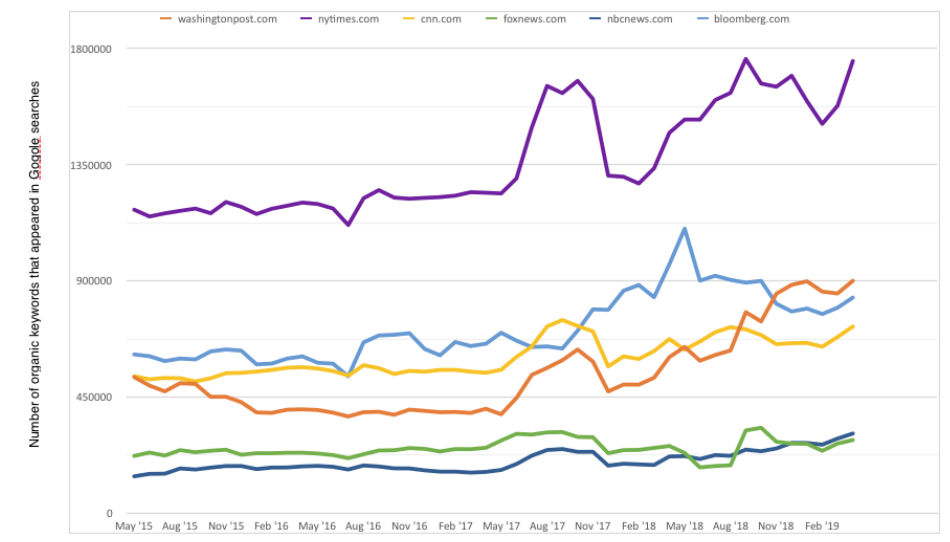
Figure 7: Estimated organic results for mainstream media websites in the United States (May